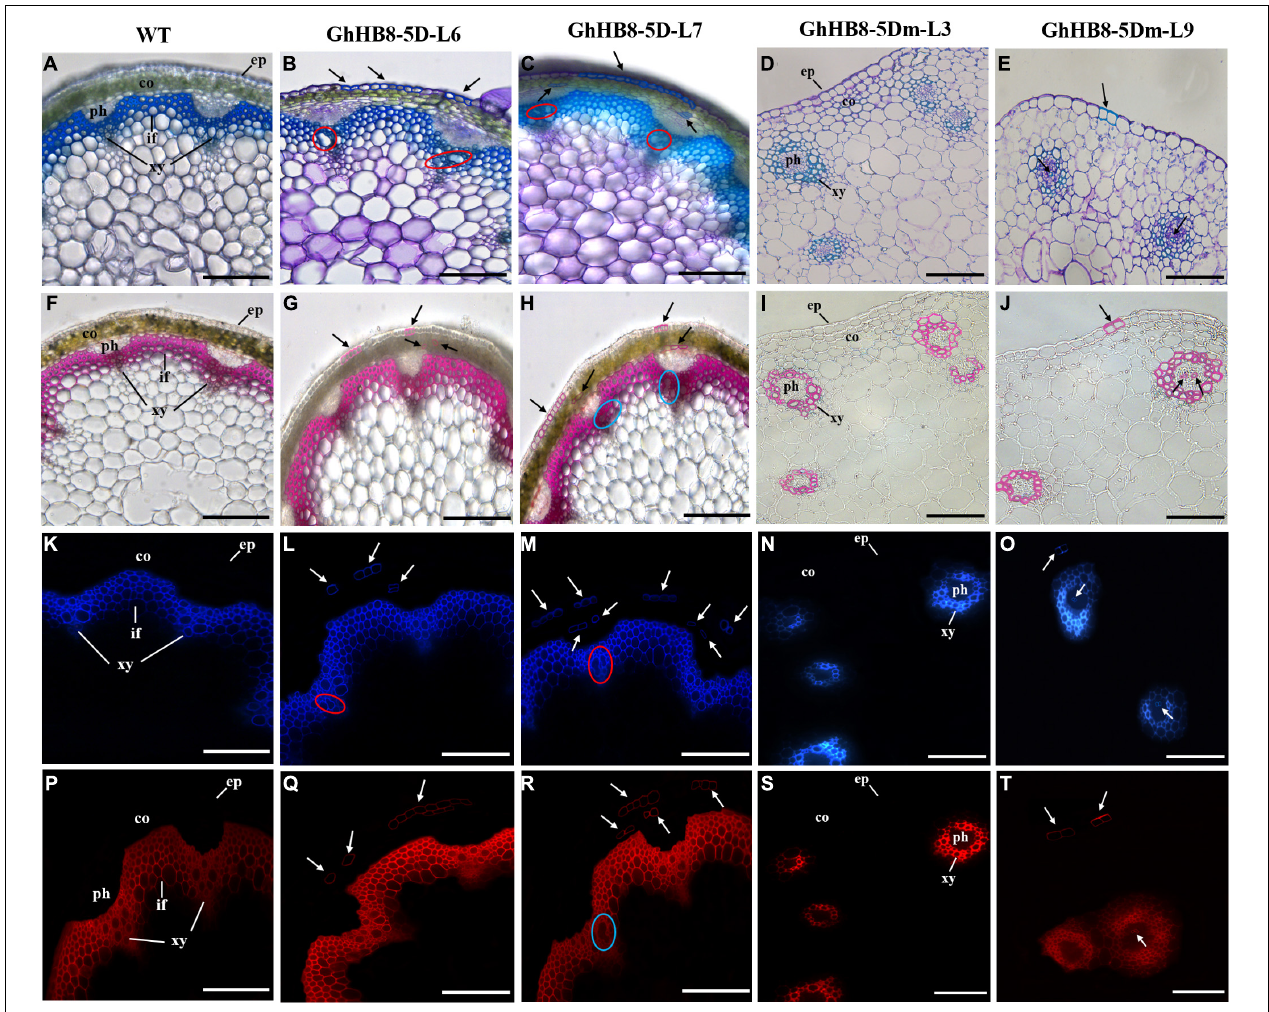
FIGURE 8 | Cross-sections of the 6-week-old stem from wild type and transgenic lines. (A–E) Toluidine blue staining of 6-week-old stems from wild type and transgenic lines. The blue regions indicate the deposition of the secondary wall; (F–J) phloroglucin staining of 6-week-old stems from wild type and transgenic lines. The red regions indicate the deposition of lignin. (K–O) Lignin autofluorescence of 6-week-old stems from wild type and transgenic lines. Regions with blue fluorescence indicate the deposition of lignin. (P–T) Pontamine Fast Scarlet 4B (S4B) staining of 6-week-old stems from wild type and transgenic lines. Regions with red fluorescence indicate the deposition of cellulose. Black arrows show ectopic deposition of the secondary wall. Red and blue circles show irregular xylem vessels. ep, epidermis; co, cortex; ph, phloem; xy, xylem; if, interfascicular fiber. Bars = 100 µ